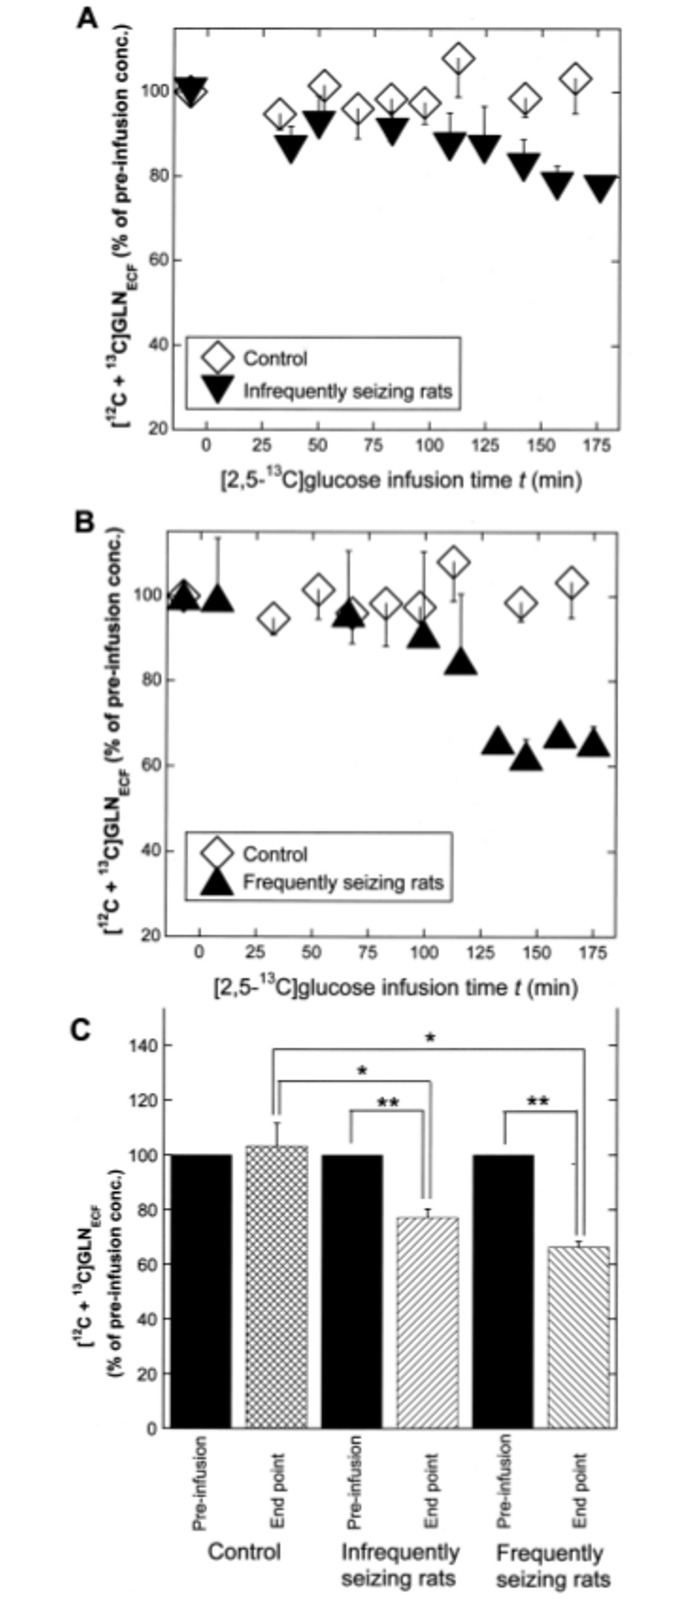
The time course of total [12C + 13C]GLNECF and comparison of the pre-infusion and the endpoint concentrations.The time course was expressed as the percentage of the pre-infusion concentration in each rat and the mean ± SE taken for each group. A. In infrequently seizing rats (inverted black triangle), the concentration decreased significantly while controls (open diamond) showed little change. B. Time course for frequently seizing rats (black triangle), showing a more pronounced decrease. C. A bar graph comparing the pre-infusion and the endpoint [12C + 13C} GLNECF in the control, the infrequently-seizing and the frequently-seizing rats. ** p < 0.01, * p < 0.05. (see text).